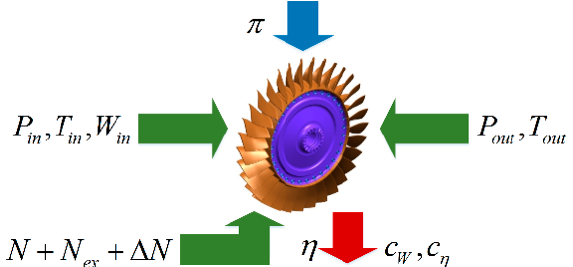
Figure 4. Turbine component inverse calculation.